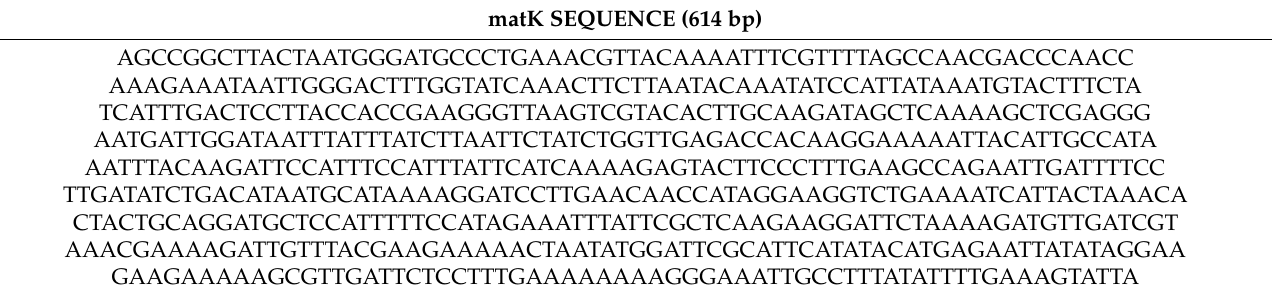
Table 2. DNA barcoding